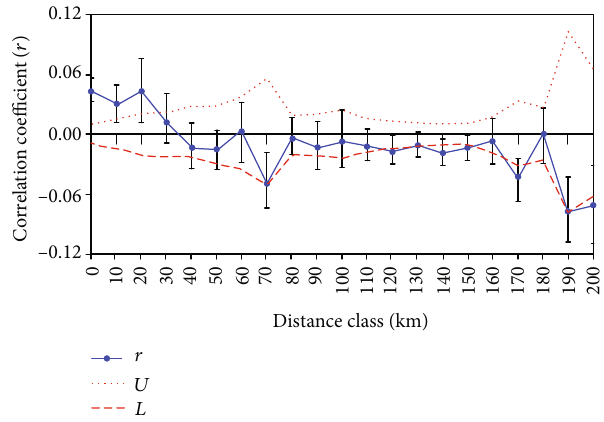
Figure 5: This graph indicates the correlation between the genetic similarity and the geographic distance matrices for Ethiopian O. crenata